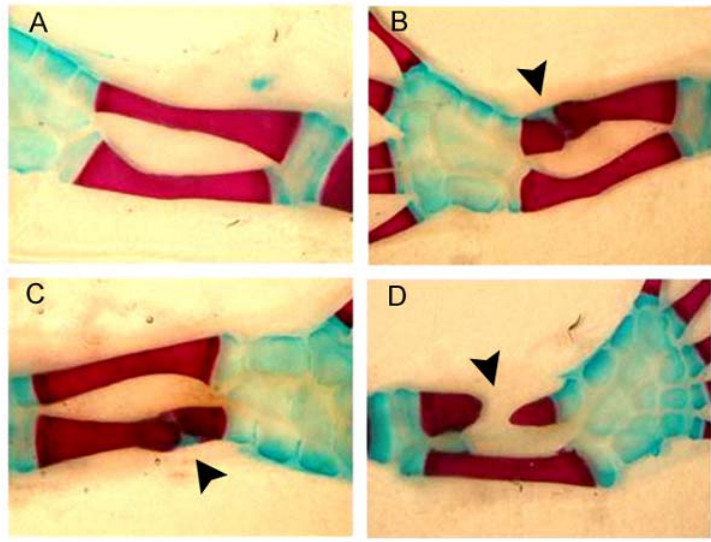
FIGURE 2. Double staining of axolotl limbs, with alizarin red (bone) and alcian blue (cartilage). (A) Control limb, sham no fracture; (B and C) depicting bone healing of the ulna for nonstabilized fractures with a callus formed of cartilage (black arrows); (D) gap of critical dimension (4 mm) with no signs of healing (black arrow). All pictures were taken 5 months